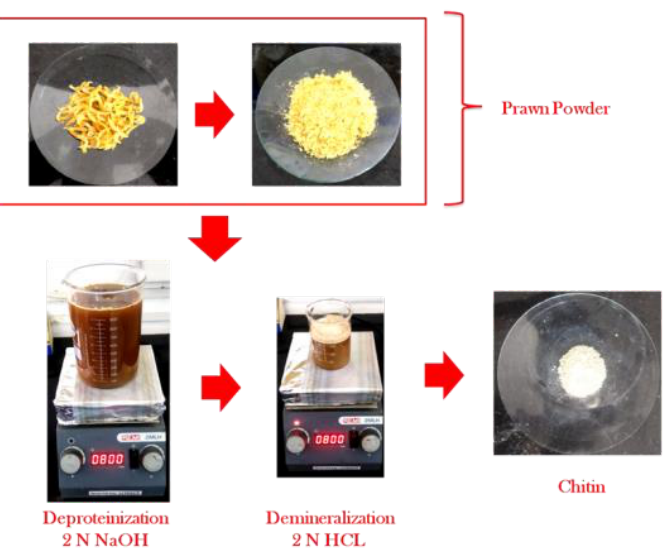
Figure 1. Schematic representation of the extraction of chitin from prawn shells.